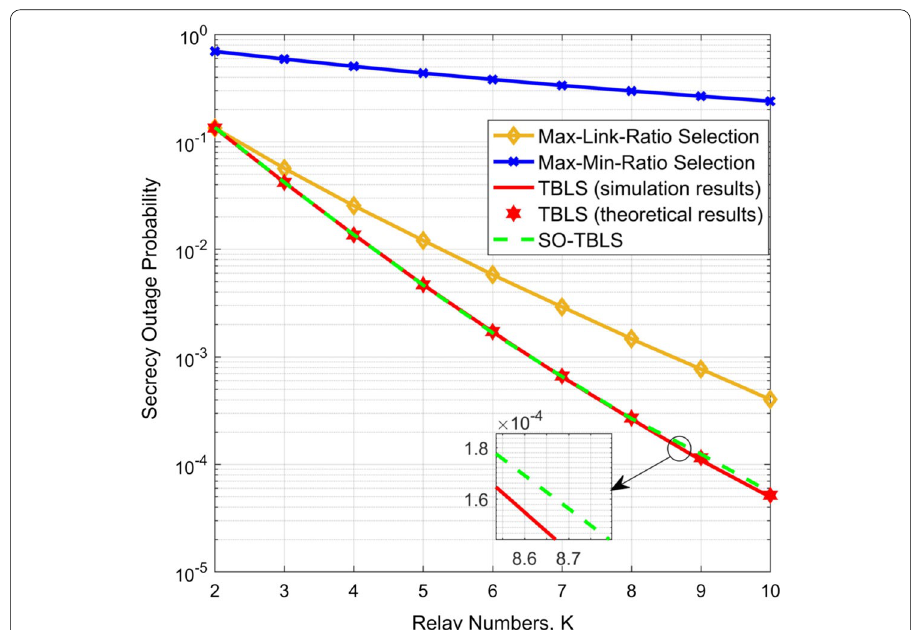
Fig. 8 The secrecy outage probability versus number of relays for different relaying protocols